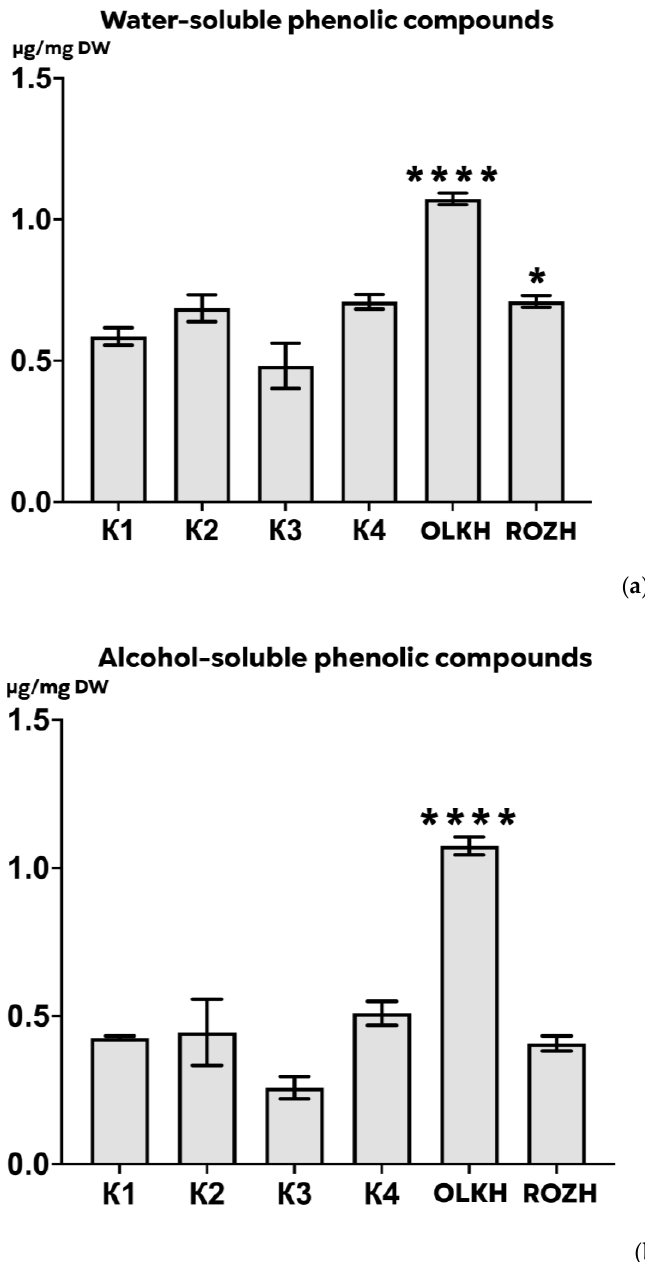
Figure 6. The concentration of water-soluble ( a ) and alcohol-soluble phenolic ( b ) compounds in tubers of H. tuberosus growing in contaminated arias and in arias without contamination. **** corresponds to p < 0.00001 significance level; * corresponds to p < 0.05 significance level. Despite the weak level of correlation between radiation exposure and the amount of alcohol-soluble phenolic compounds, there was a significantly significant increase in their level in the OLKH variant compared to the control variants ( p < 0.00001), as well as an average level of correlation between radiation exposure and the amount of water-soluble phenolic compounds. Moreover, in both experimental samples, a significant increase in the concentration of water-soluble phenolic compounds was observed compared to the control variants ( p < 0.00001 and p < 0.5 in OLKH and ROZH, respectively). Based on our